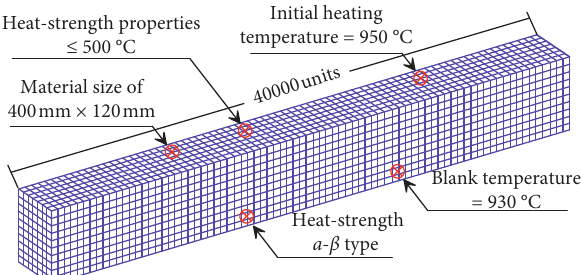
Figure 2: Establishment of the geometric model and its unit di- vision of the metal material in solid-state